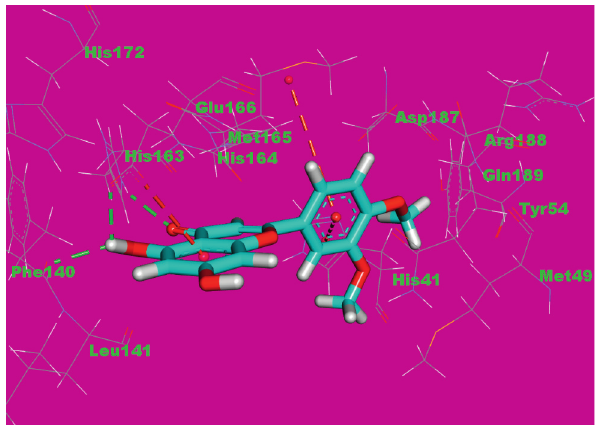
Figure 5: Compound (2) docked into the active site of the COVID- 19 main protease. The hydrogen bonds are represented in green dashed lines, and the hydrophobic interactions are represented in orange dashed lines.